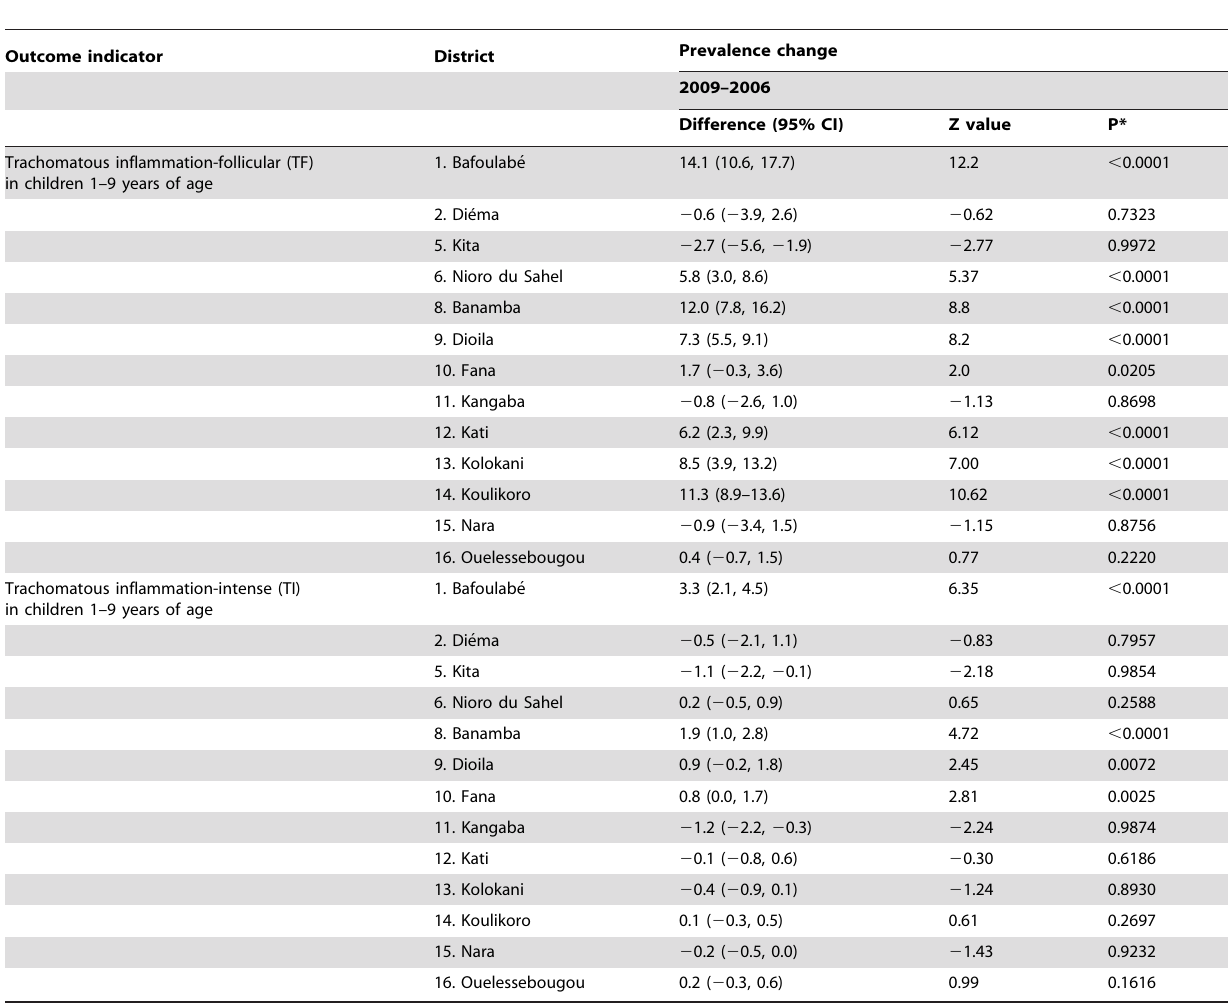
Table 5. Difference in district-level prevalence estimates of active trachoma signs among children 1–9 years of age in 2006 and 2009 in Kayes and Koulikoro Regions,